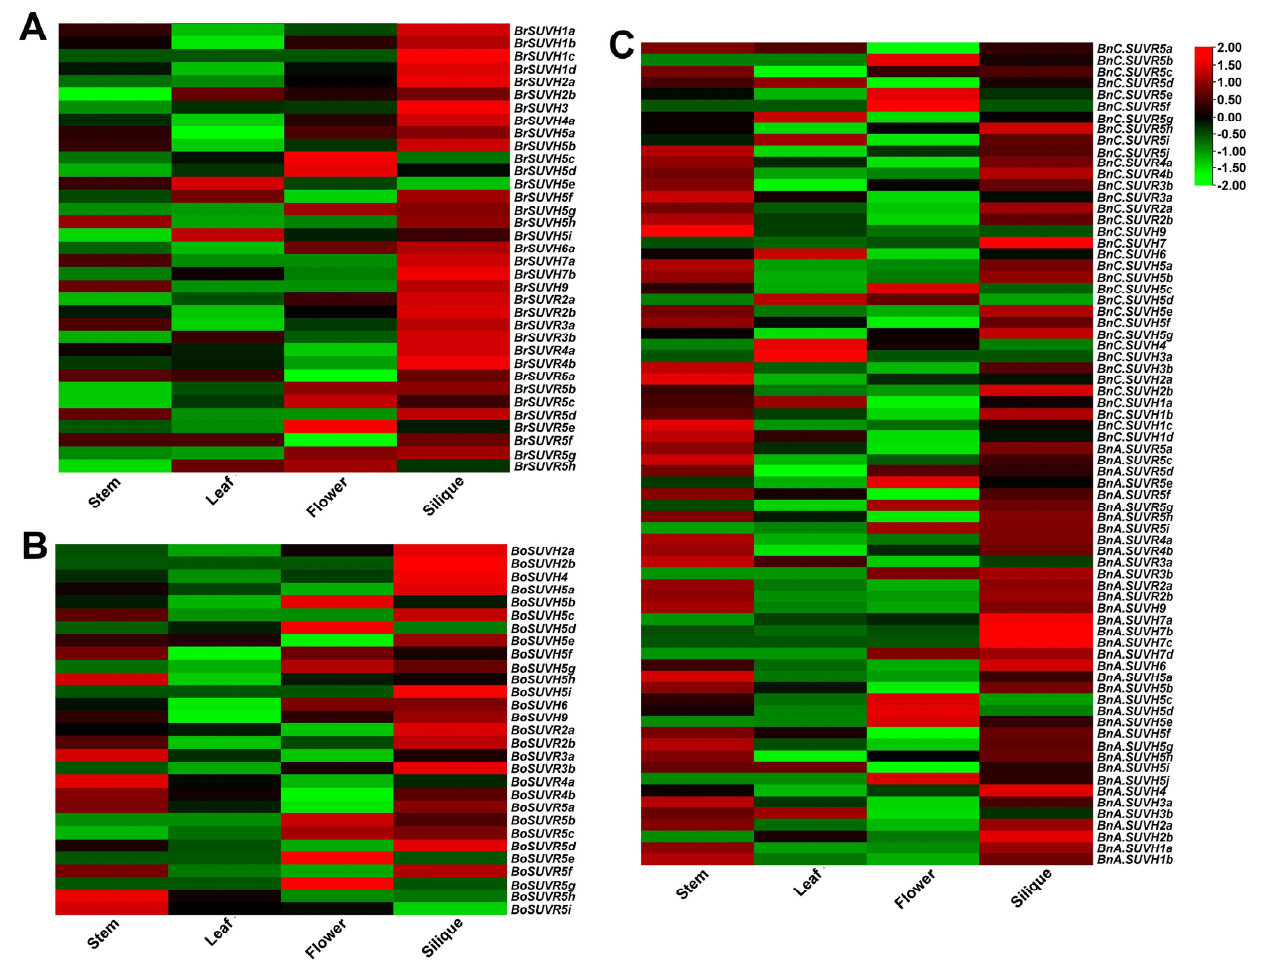
Figure 9. Expression patterns of SUV genes in four tissues (stem, leaf, flower, silique) of B. rapa ( A ), B. oleracea ( B ) and B. napus ( C ).